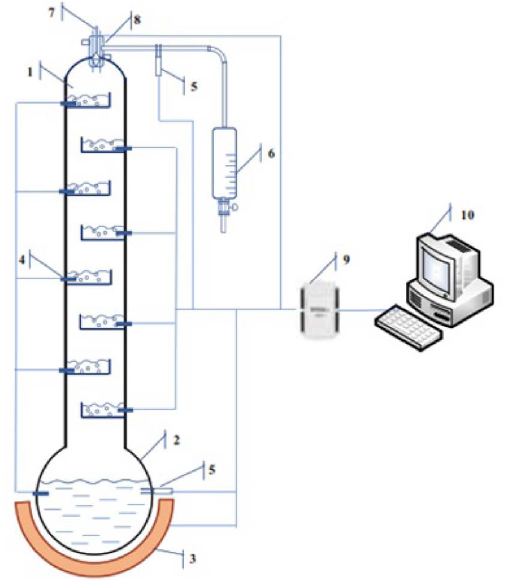
Fig. 4. Schematic diagram for the batch distillation column (1 – Vessel; 2 – Still Pot (boiler); 3 – Heating mantle; 4 – Temperature sensors; 5 – Condenser; 6 – Product receiver; 7 – Solenoid valve; 8 – Conductivity; 9 – DAQ; 10 – PC.